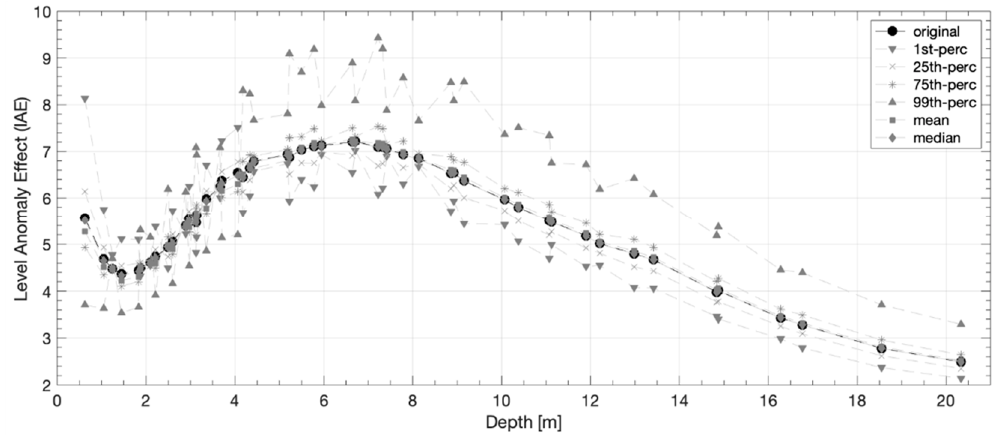
Figure 9. The DD and PD level anomaly effect (lAE) for the original and simulated (25th percentile, 75th percentile, maximum, mean, median, and minimum) datasets obtained with an input voltage of 200 V.